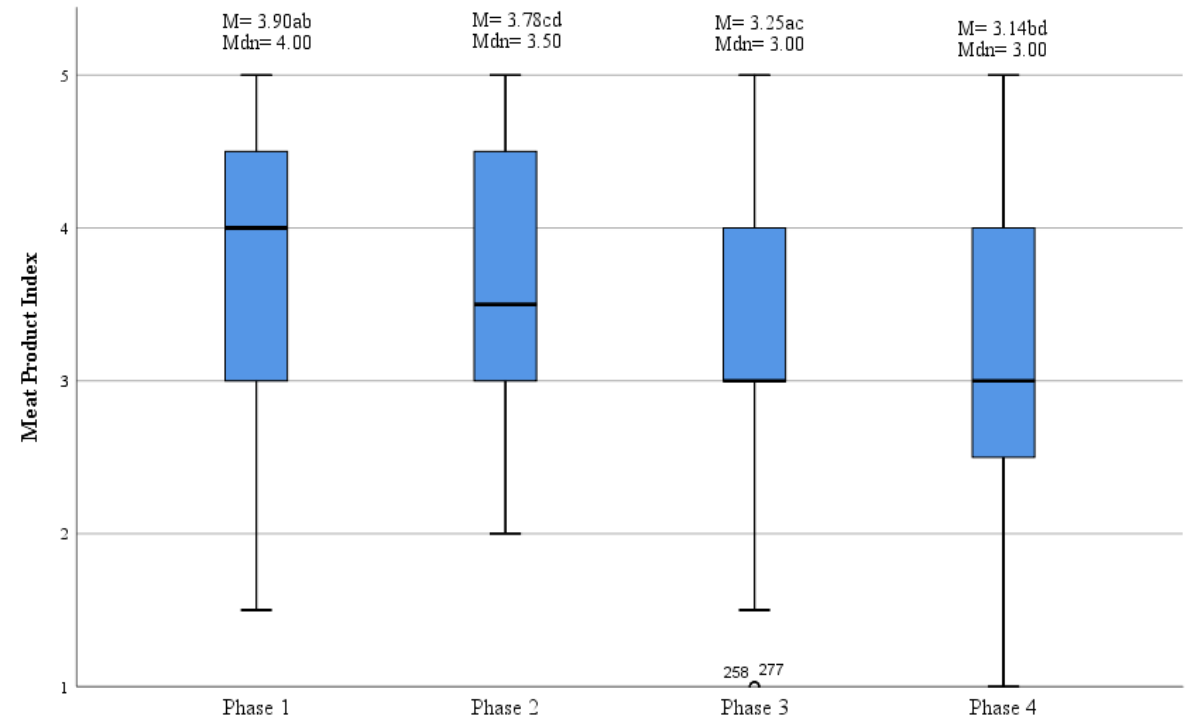
Figure 1. Meat Products Index distribution among respondents in phases of change in meat consumption. M—mean, Mdn—median. The values with different superscripts indicate significant differences in Tukey’s post-hoc test results ( p < 0.001). Designation of frequency scale: 5—several times a